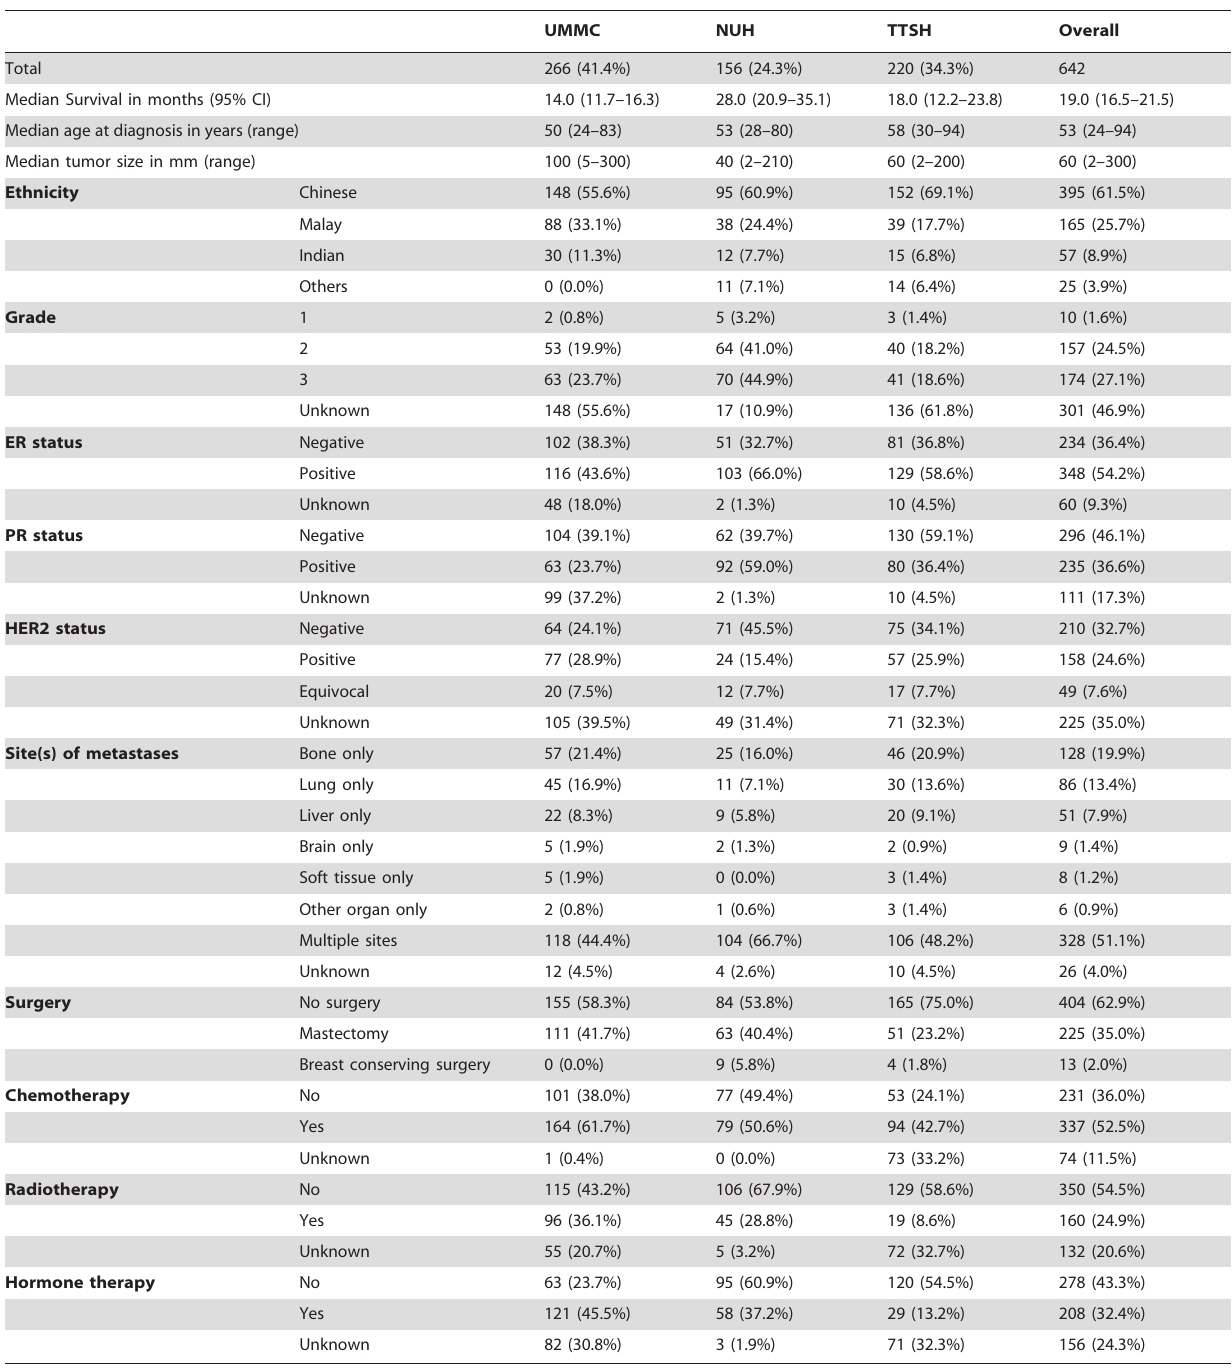
Table 3. Characteristics of de novo metastatic breast cancer patients identified at NUH, TTSH and UMMC,